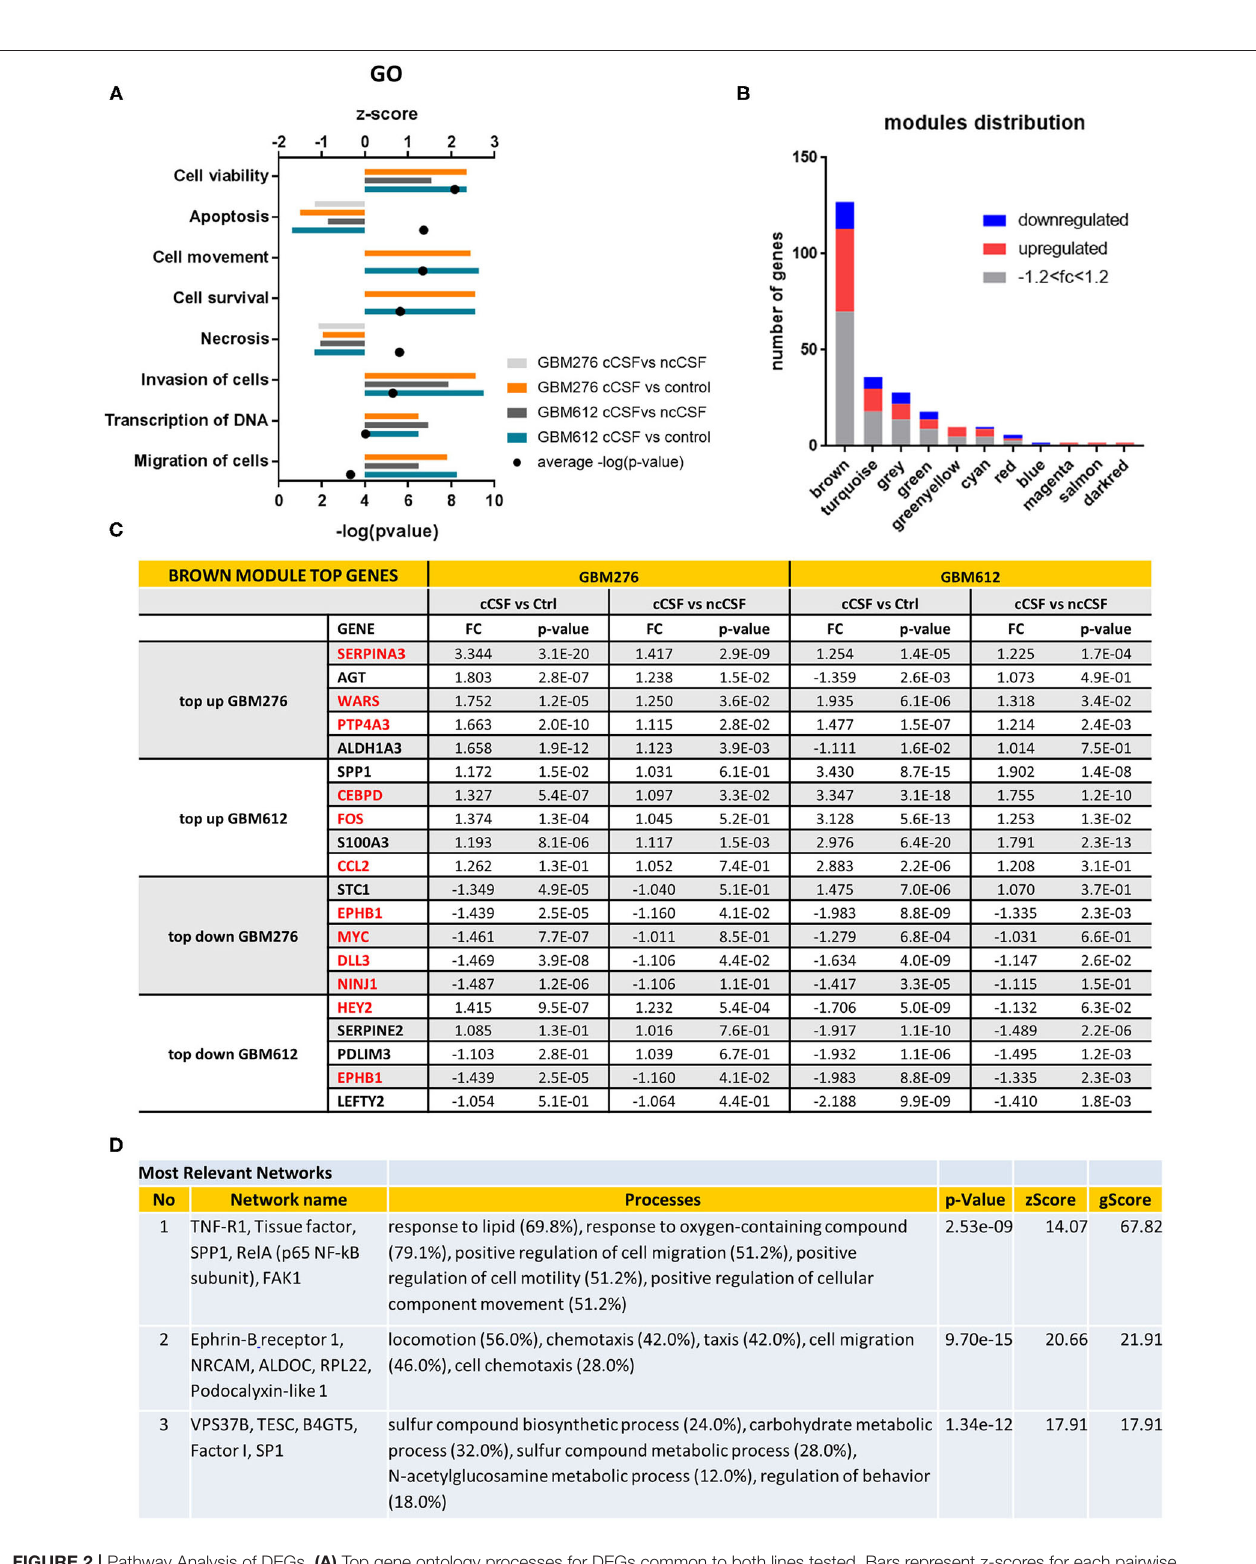
Frontiers in Oncology |